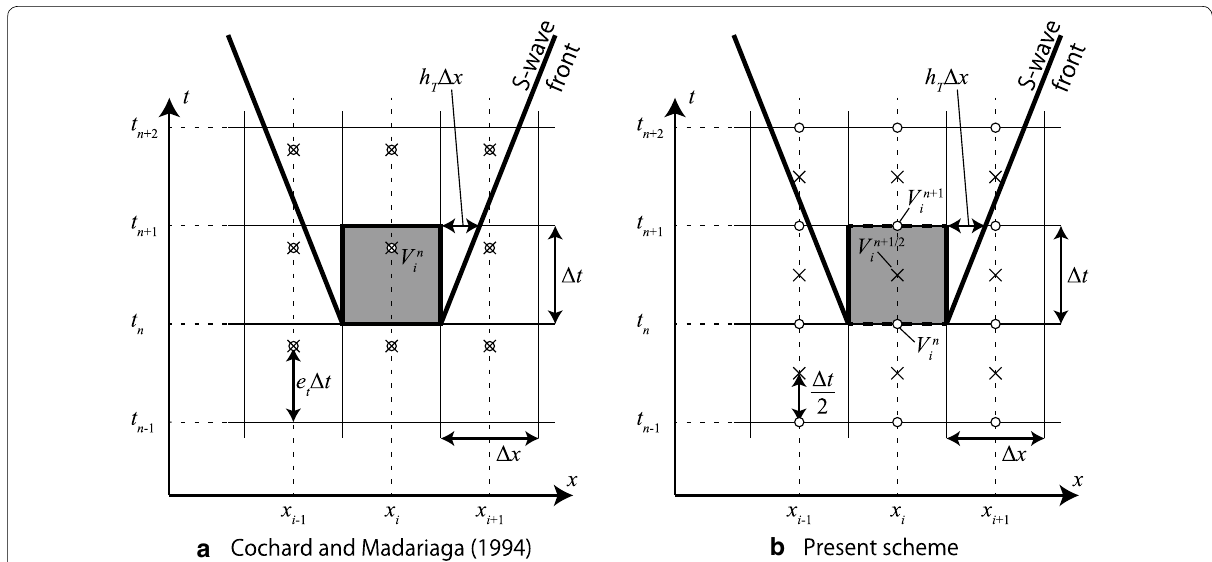
Fig. 1 Schematic diagrams of spatiotemporal discretization for time-marching schemes investigated in the present study. a Cochard and Madariaga (1994) (CM) and b the present scheme (NL). Collocation points where V and τ are defined are indicated by circles, and V at the points indicated by crosses are stored and used in numerical integration. Piecewise-constant approximation was adopted in both schemes, and a basis function is indicated by a gray square. Thick dashed line in b indicates that the collocation points (circles) are not included in the support of the basis